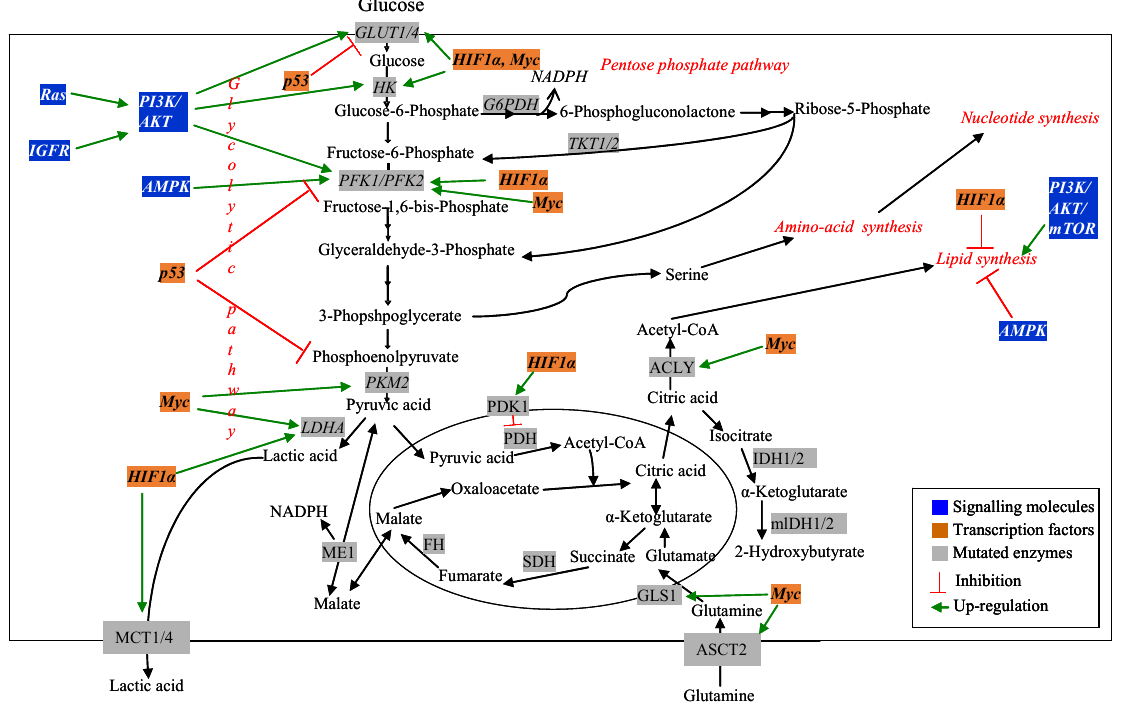
Figure 2. Dysregulated metabolic pathways and their regulators in